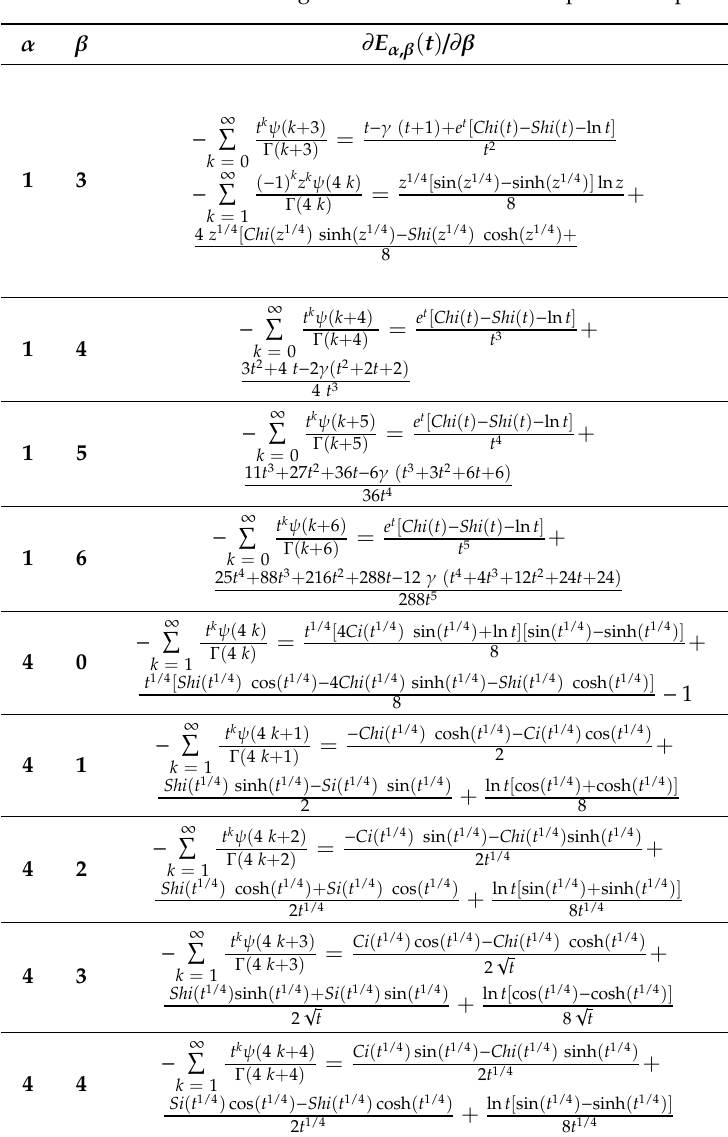
Table 2. First derivatives of the Mittag-Le ffl er functions with respect to the parameter β